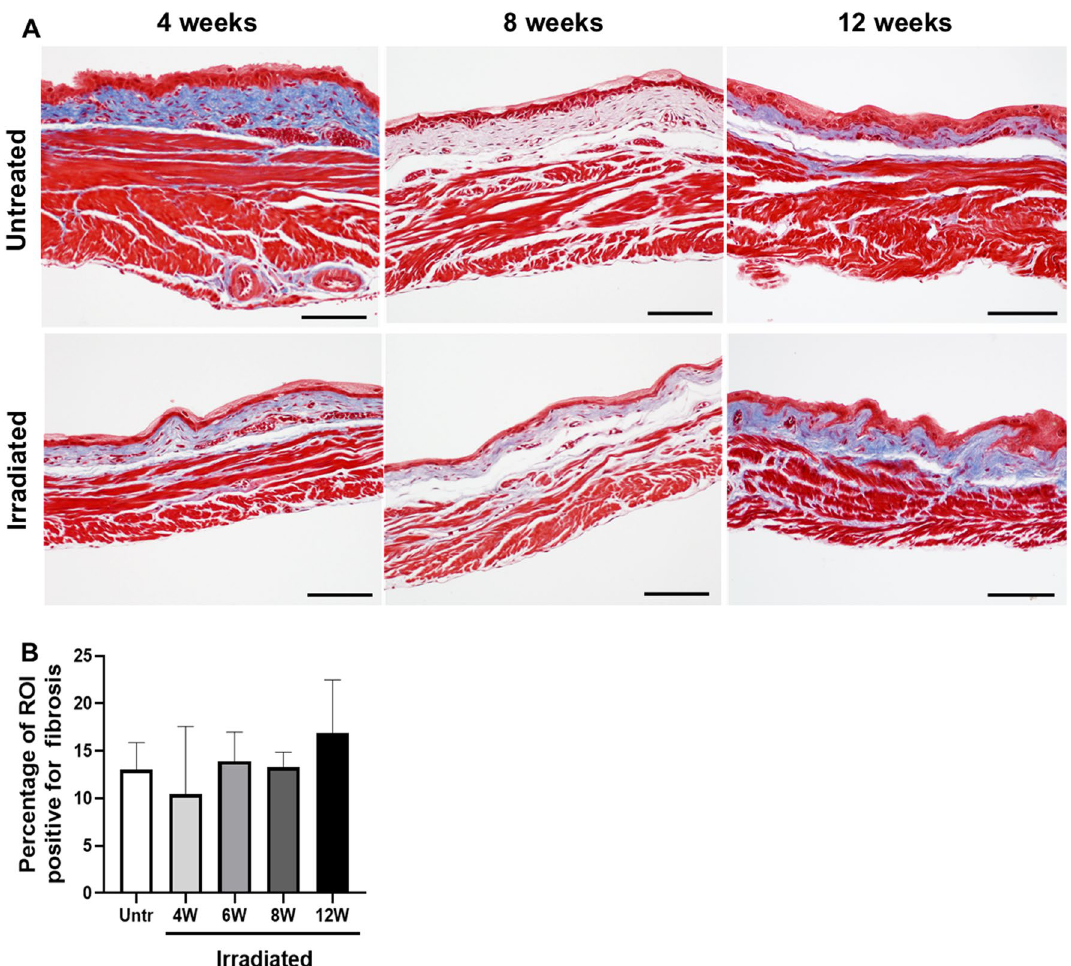
Figure 6. Amount of fibrous tissue in the bladder is unaltered during the acute phase of RC. ( A ) Masson’s trichrome staining was performed on untreated and irradiated bladder sections at 4, 8, and 12 weeks after radiation treatment. ( B ) Quantification of fibrous tissue was performed for untreated (n = 3) and irradiated (n = 3/group) bladder tissues. Fibrous tissue = blue; Scale bar = 100